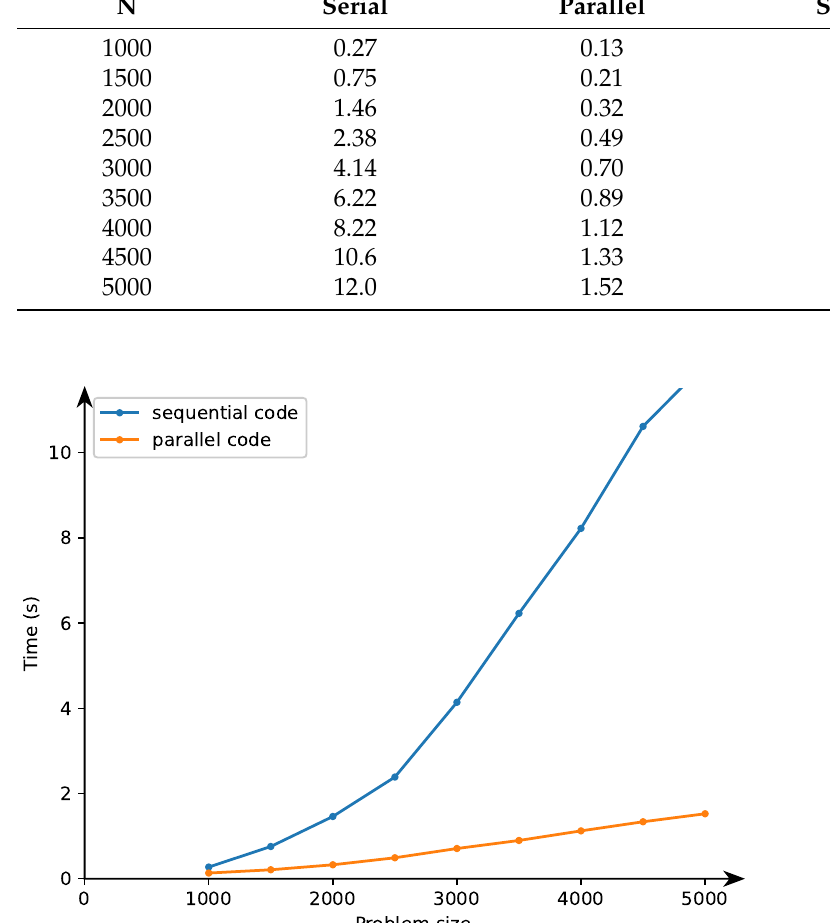
Figure 2. Time for Intel Xeon X5570 and different problem